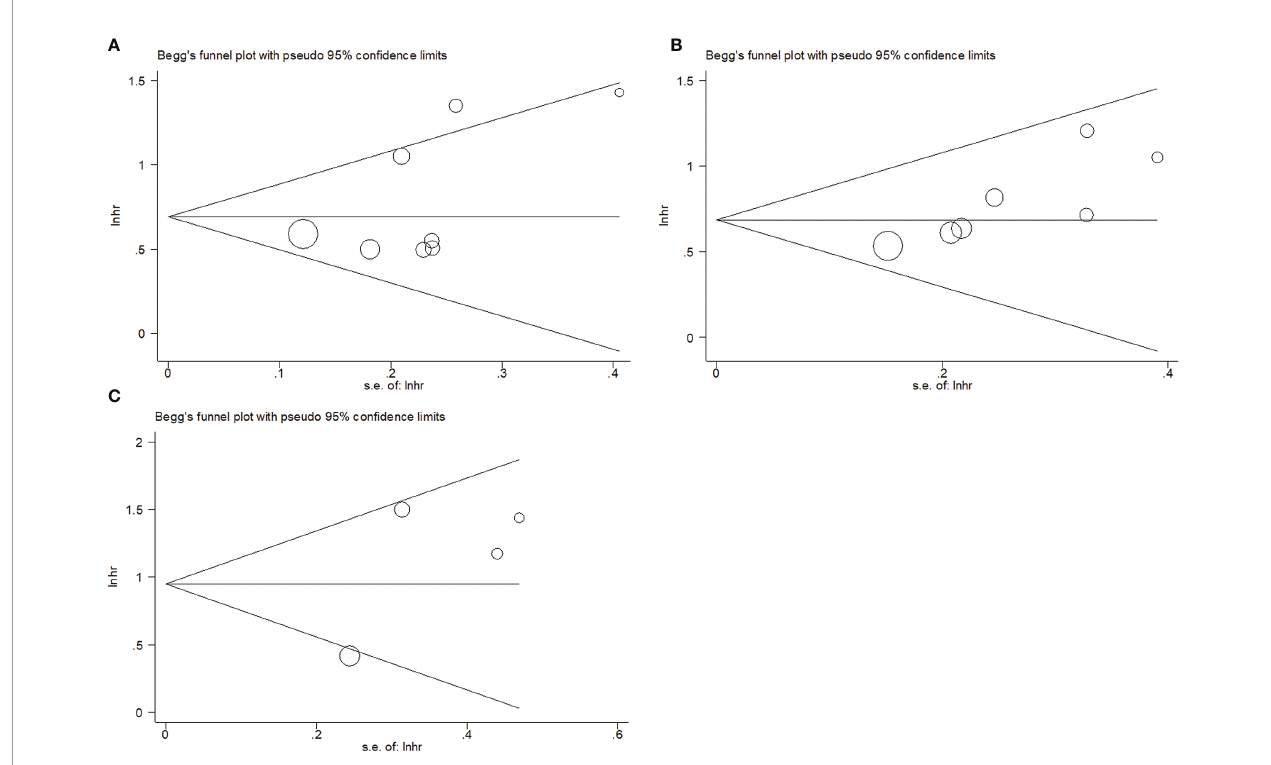
FIGURE 6 | Publication bias test by Begg ’ s funnel plots for (A) OS, (B) PFS/DFS/RFS, and (C)